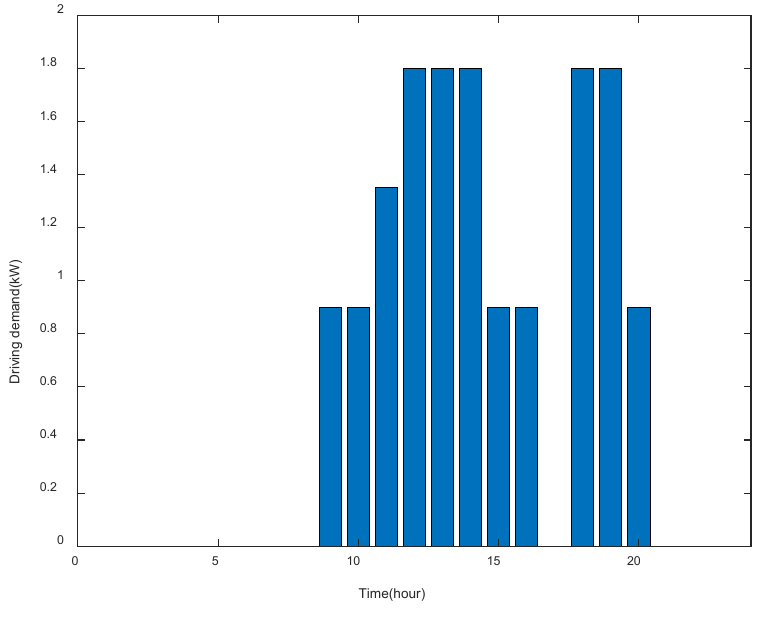
Figure 3. Initial driving demand of EV .